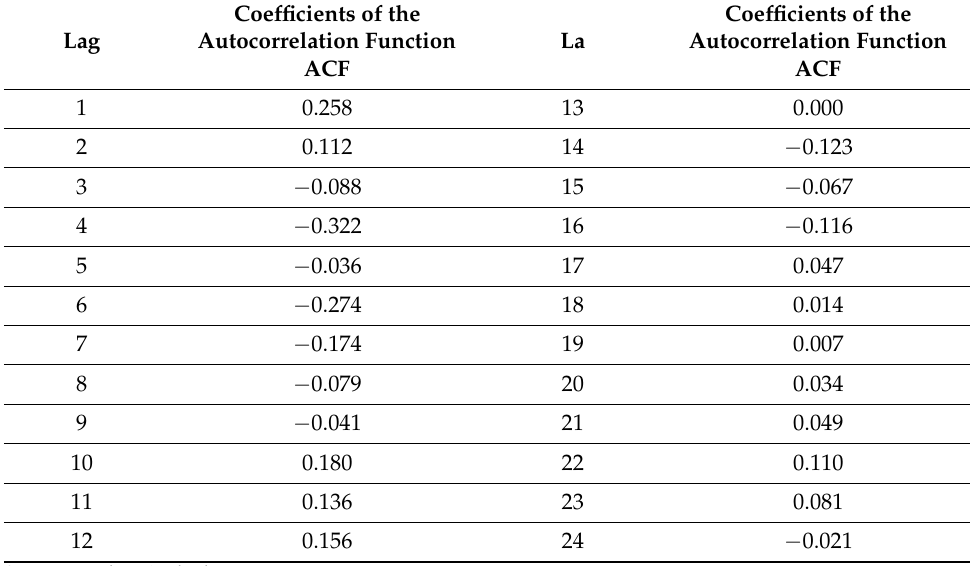
Table A7. Coefficients of the two autocorrelation functions.